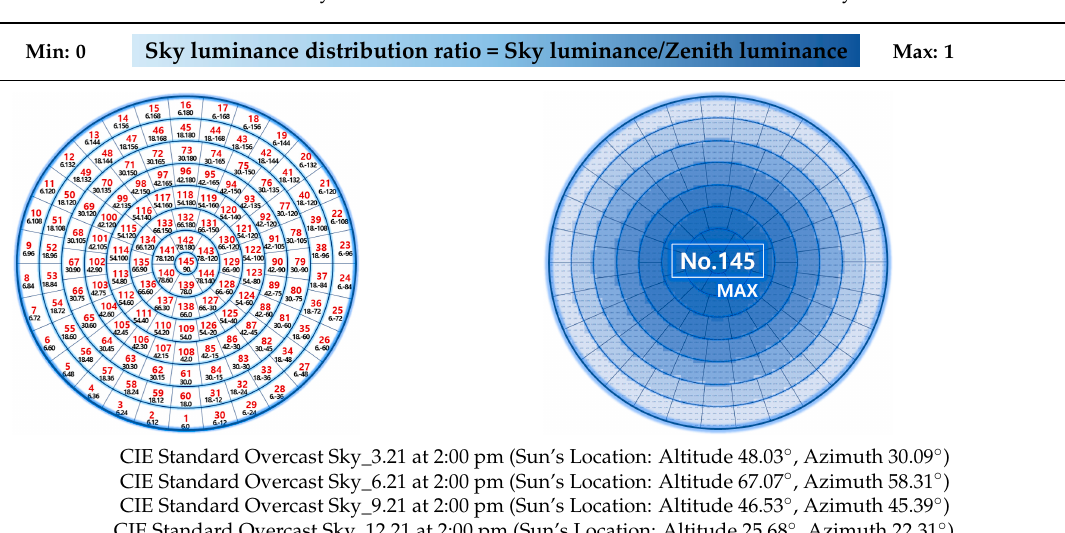
14 of 36 14 of 36